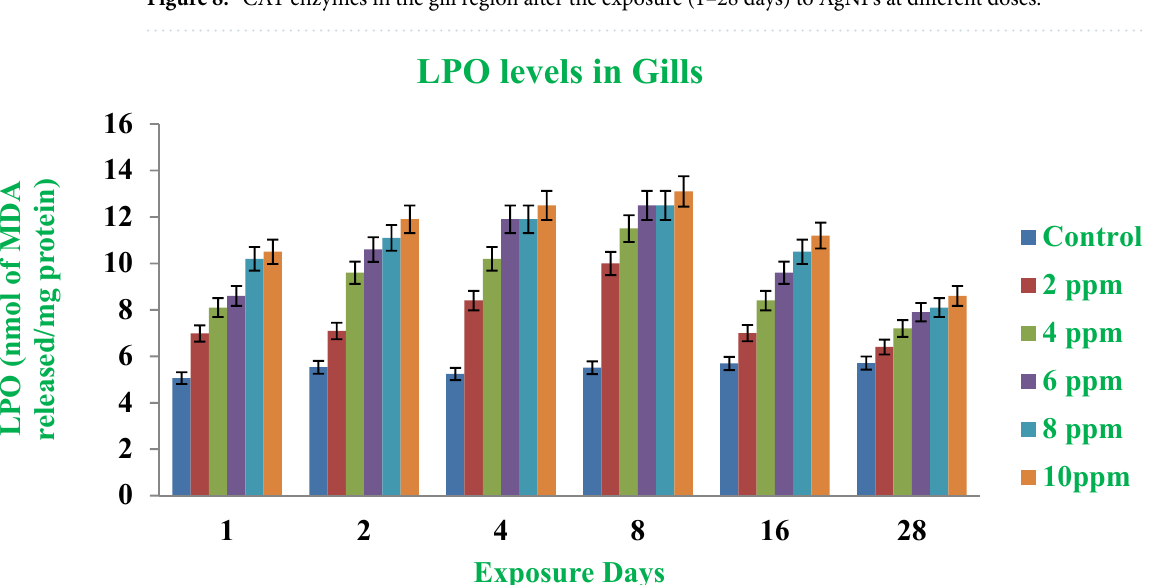
Figure 9. LPO enzymes in the gill region after the exposure (1–28 days) to AgNPs at different